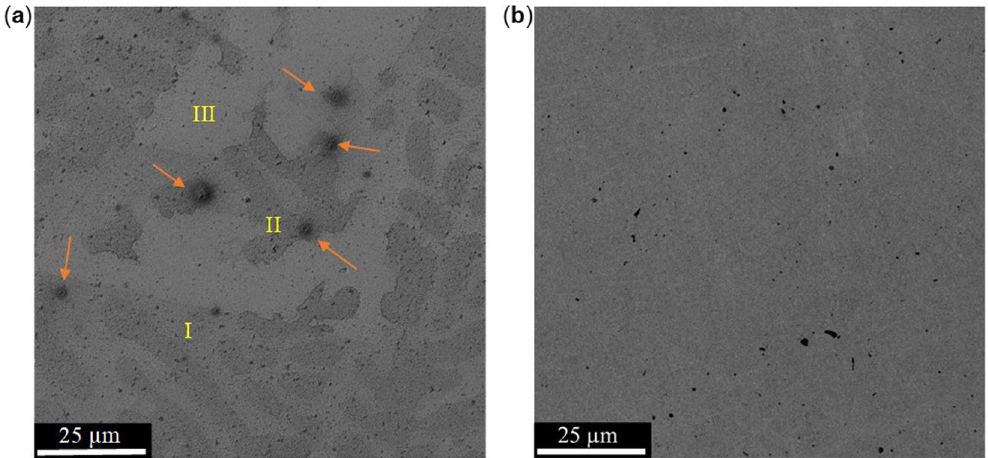
Fig. 3 BSE-SEM images post 2-week immersion in 0.6 M NaCl of SS 304L and the AlFeMnSi alloy. BSE-SEM images (5 kV accelerating voltage) after 2-week immersion in 0.6 M NaCl of a the AlFeMnSi alloy (arrows point toward pores) and b SS 304L.